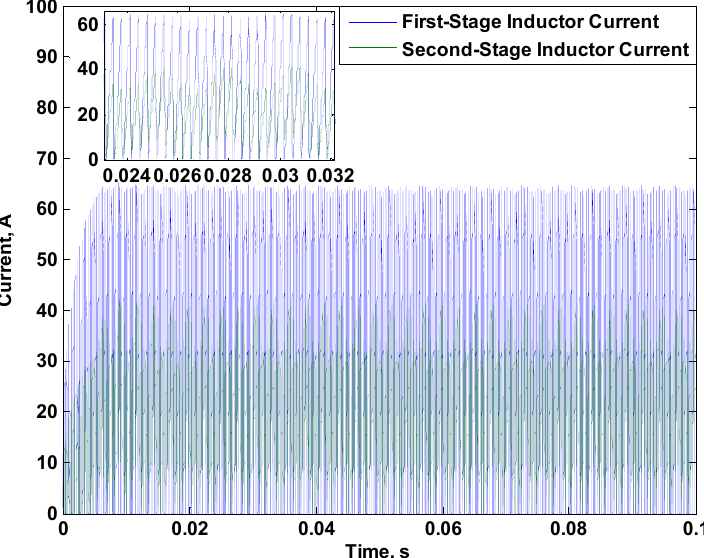
Figure 19. Output, first-stage capacitor and second-stage capacitor voltages at a reference voltage of 200 V during the reduction of the first-stage source voltage to 12 V.